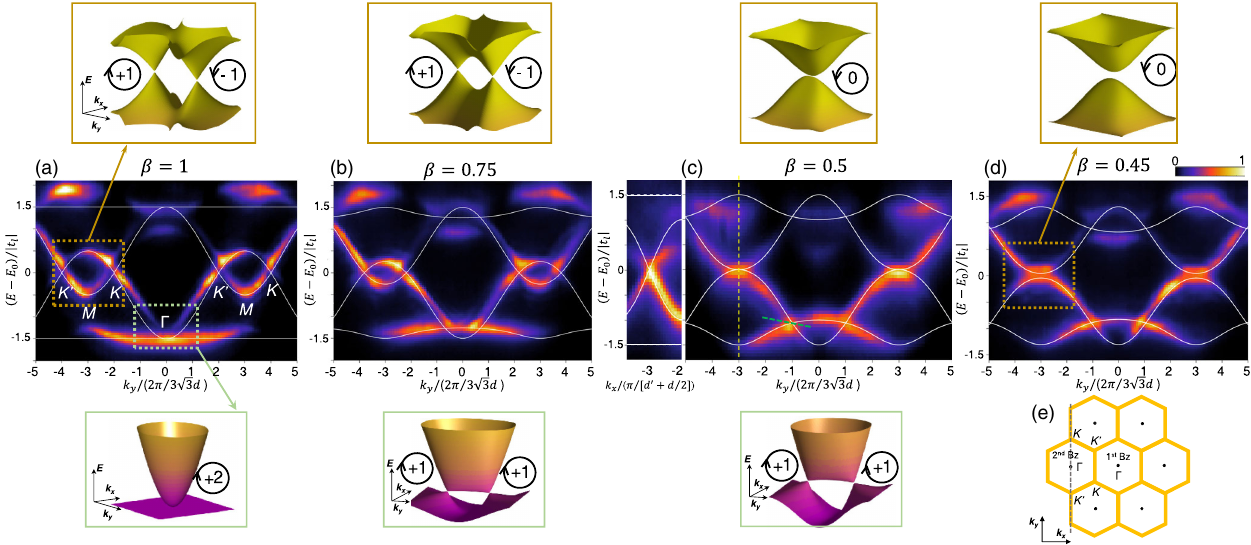
FIG. 3. Tilted Dirac cones in orbital graphene under strain. The central panels (a) – (d) show the measured polariton photoluminescence intensity as a function of k for different values of β (the color scale of each panel has been independently normalized to its maximum y ¼ 2 π = ð d 0 þ d= 2 Þ , dashed line in (e). Note that d ¼ 2 . 40 μ m for the unstrained coupling, while for the value). The plot is done for k x strained coupling, d 0 is 2 . 40 μ m, 2 . 60 μ m, 2 . 70 μ m, and 2 . 72 μ m, respectively, in (a) – (d). Here, E 0 ¼ 1 . 5687 eV and photon-exciton detuning δ ¼ − 10 meV at the energy minimum of the p bands for panels (a), (b), and (d); E 0 ¼ 1 . 5780 eV and δ ¼ − 2 meV for panel ¼ − 0 . 90 meV for panel (a), − 0 . 85 meV for panels (b) and (d), and − 0 . 65 meV for panel (c), which are obtained by fitting the (c); t L measured spectra with a tight-binding Hamiltonian (fits are shown as white lines). The left inset of panel (c) shows the semi-Dirac dispersion measured along k for the value of k marked by a yellow dashed line in panel (c). The upper row in panels (a) – (d) depicts x y the calculated tight-binding bands for energies close to E 0 [orange dashed rectangle in (a)] and the winding around the Dirac points. The bottom row shows the tight-binding bands in the region at the bottom of the bands [green dashed rectangle in (a)] together with the windings. (e) Sketch of the Brillouin zones in momentum